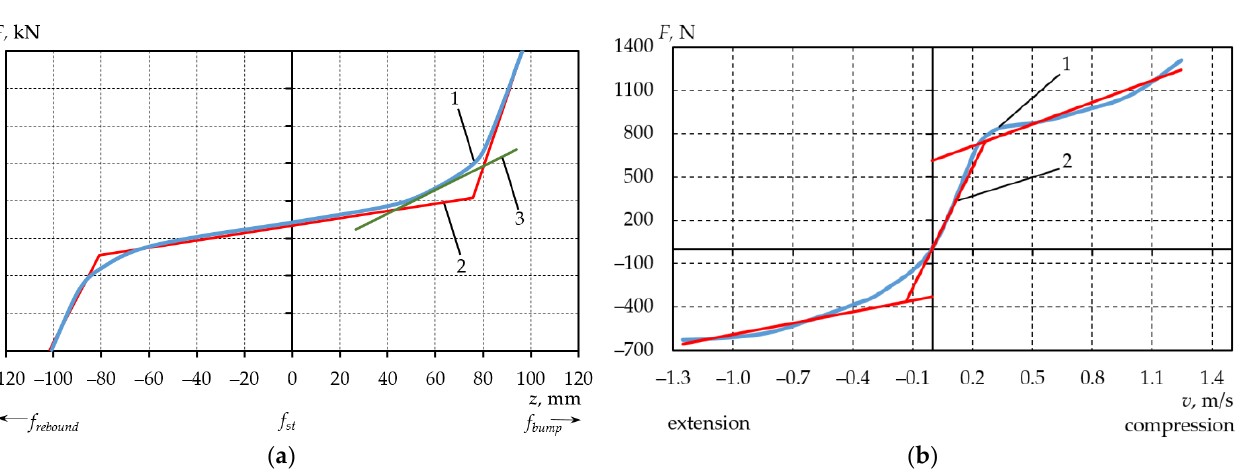
Figure 10. Modeling of suspension characteristics: ( a ) — elastic characteristic; ( b ) — damping characteristic of the damper; 1 — typical characteristic; 2 — simulated characteristic; 3 — inflection zone refinement.